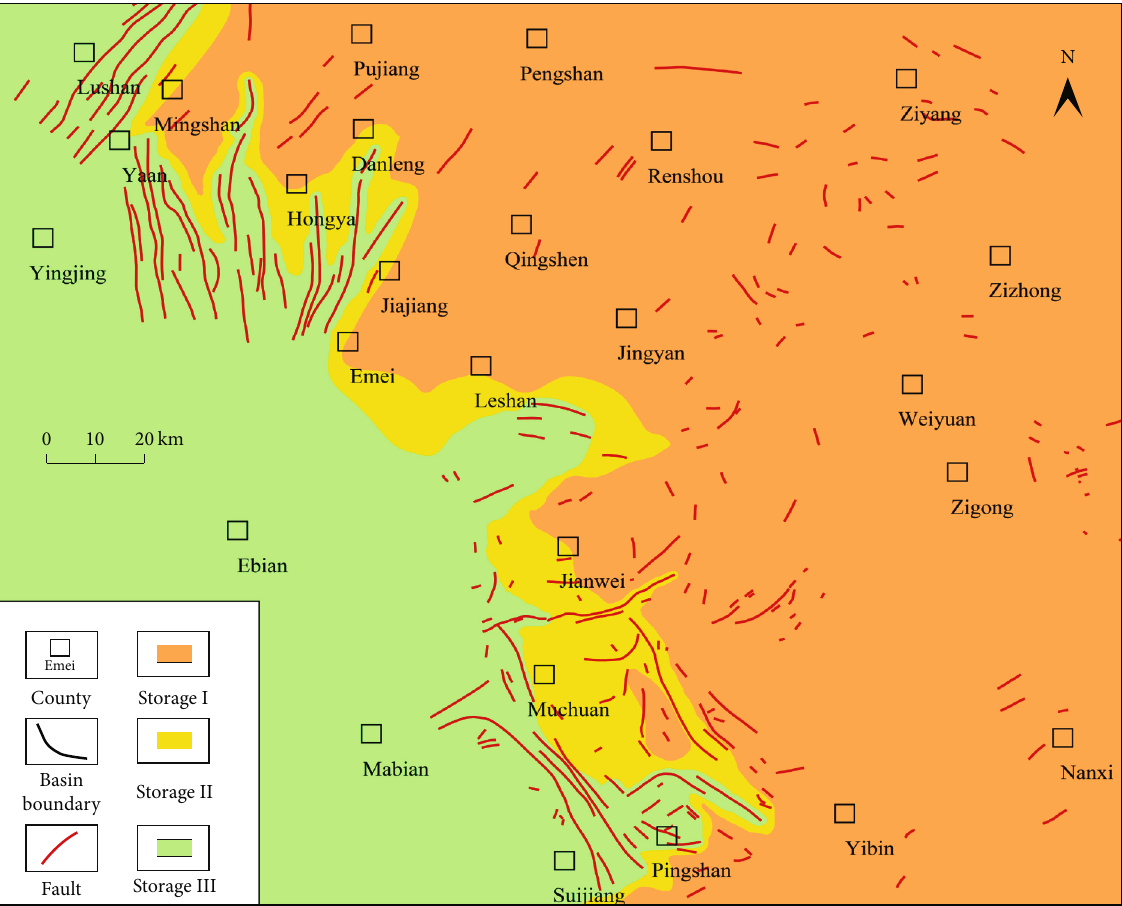
Figure 9: Planar distribution of the comprehensive evaluation of hydrocarbon preservation in the Cambrian strata in the southwestern Sichuan